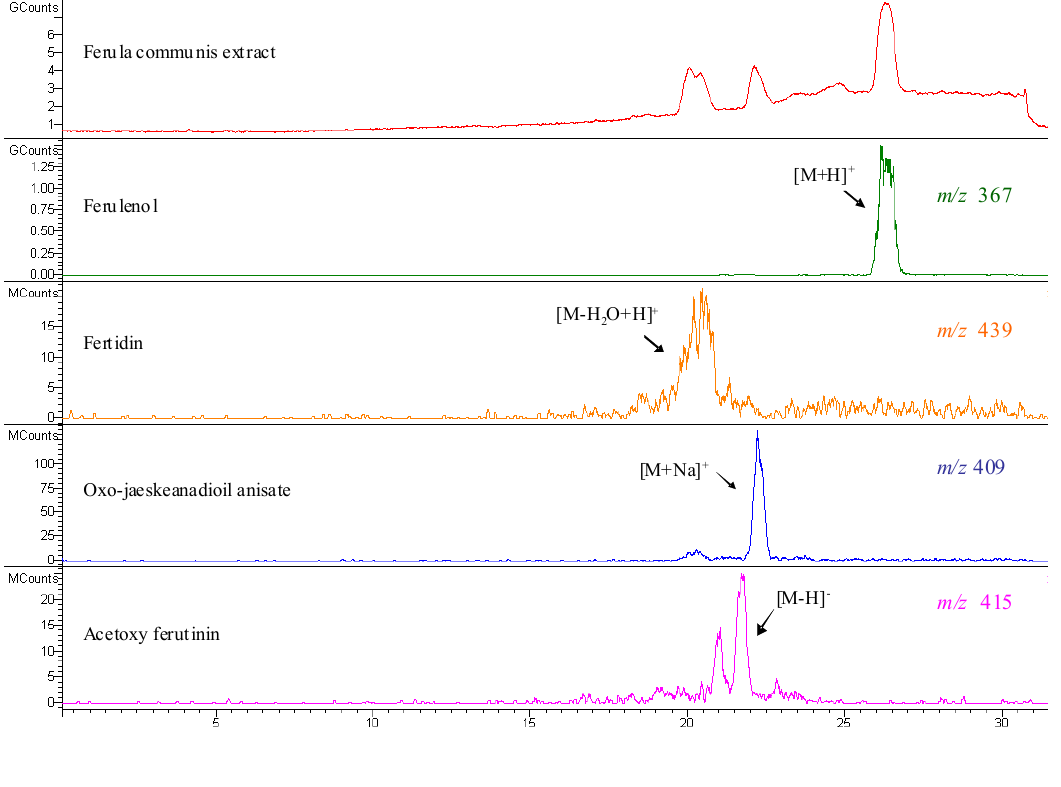
Figure 4. ESI total ion chromatogram of Ferula communis extracts and selected ion monitoring for each